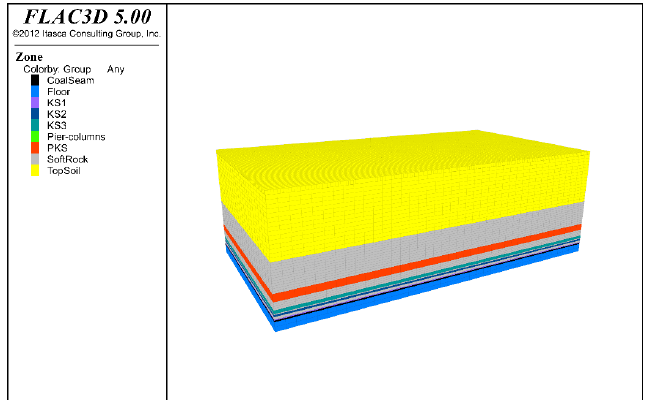
Figure 2. Numerical model. Table 2. Mechanical